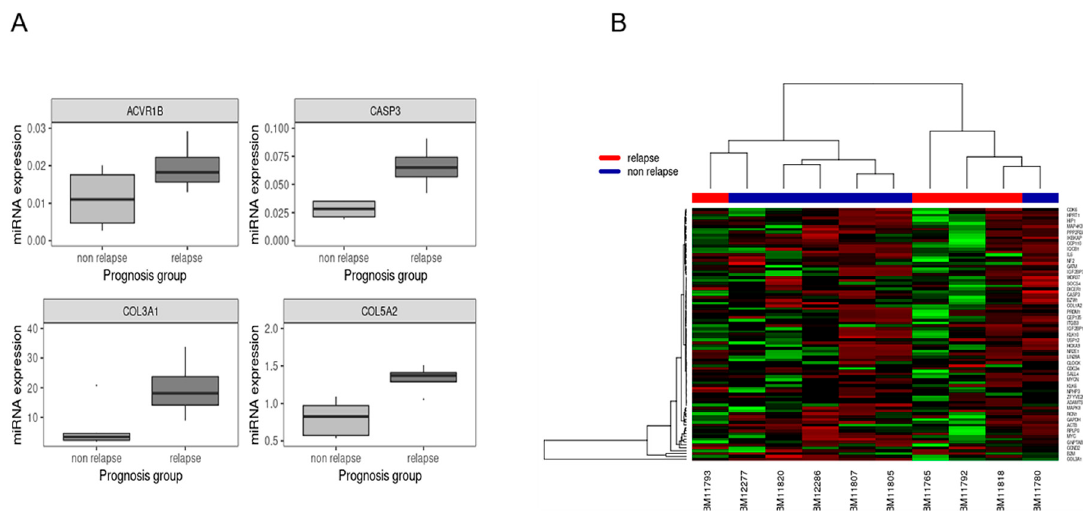
Figure 2. ( A ) Boxplot of the 4 mRNAs showing di ff erential expression between relapse and